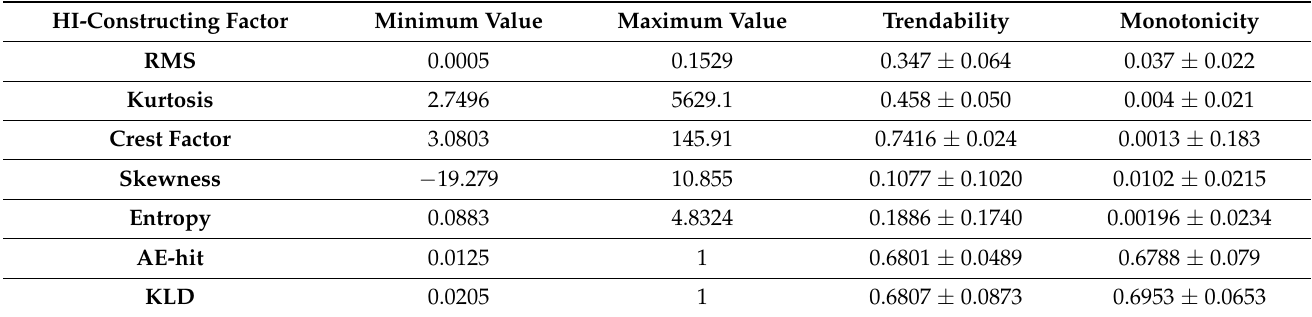
Table 1. Fitness analysis of the proposed HI-constructing factor and other